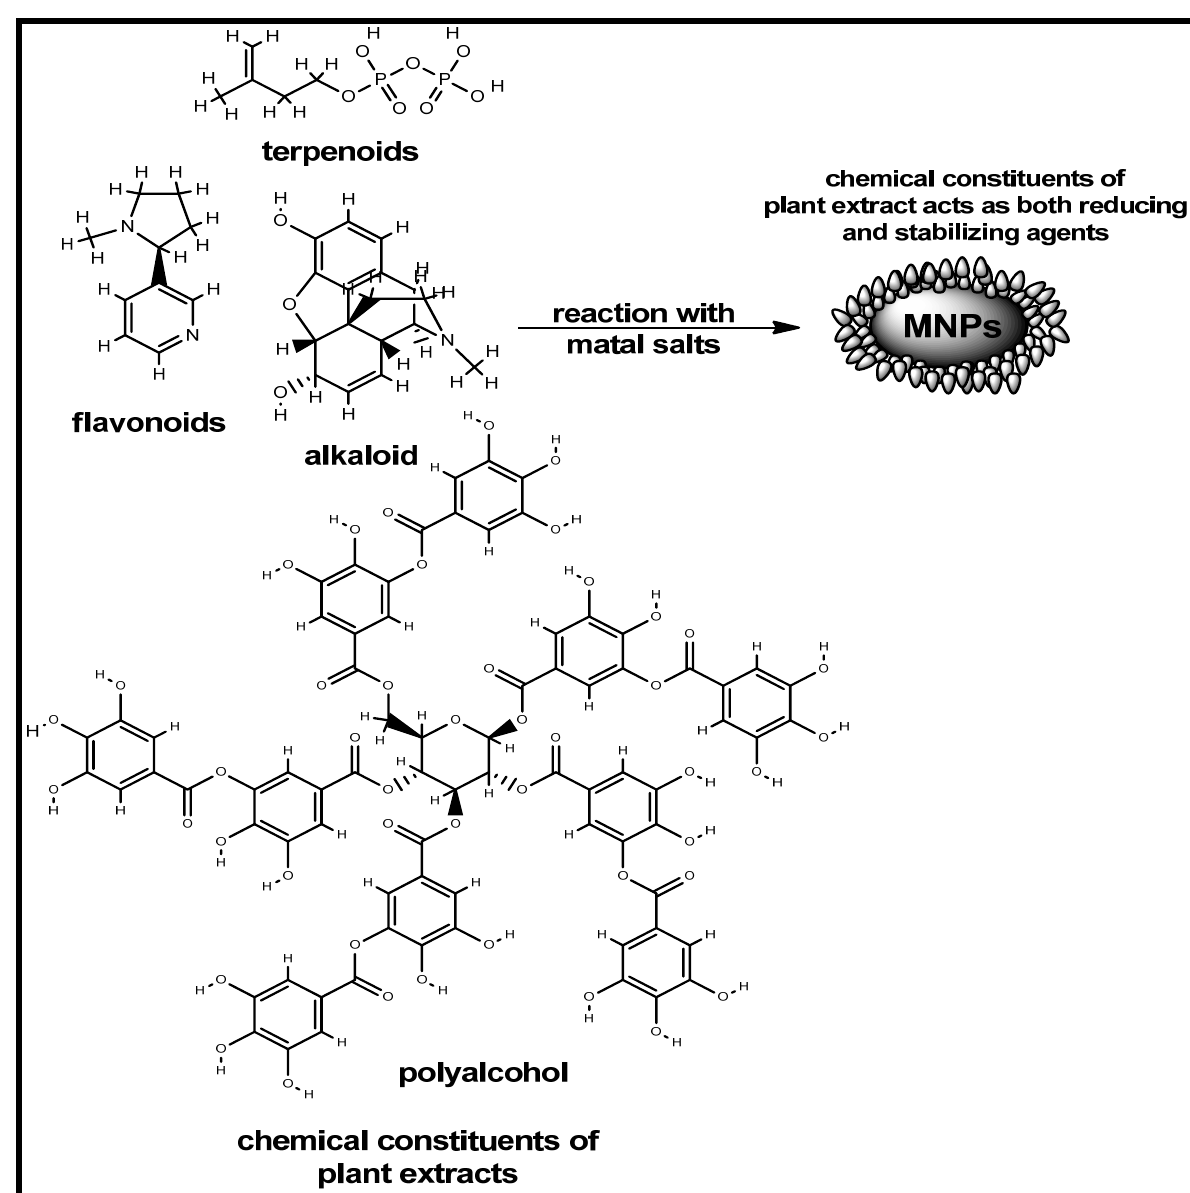
Figure 2. Selected possible constituents of plant extract responsible for the bio ‐ reduction of the metal salts during the synthetic preparation. Redrawn from [34,35], with permission from Elsevier (Copyright 2022).